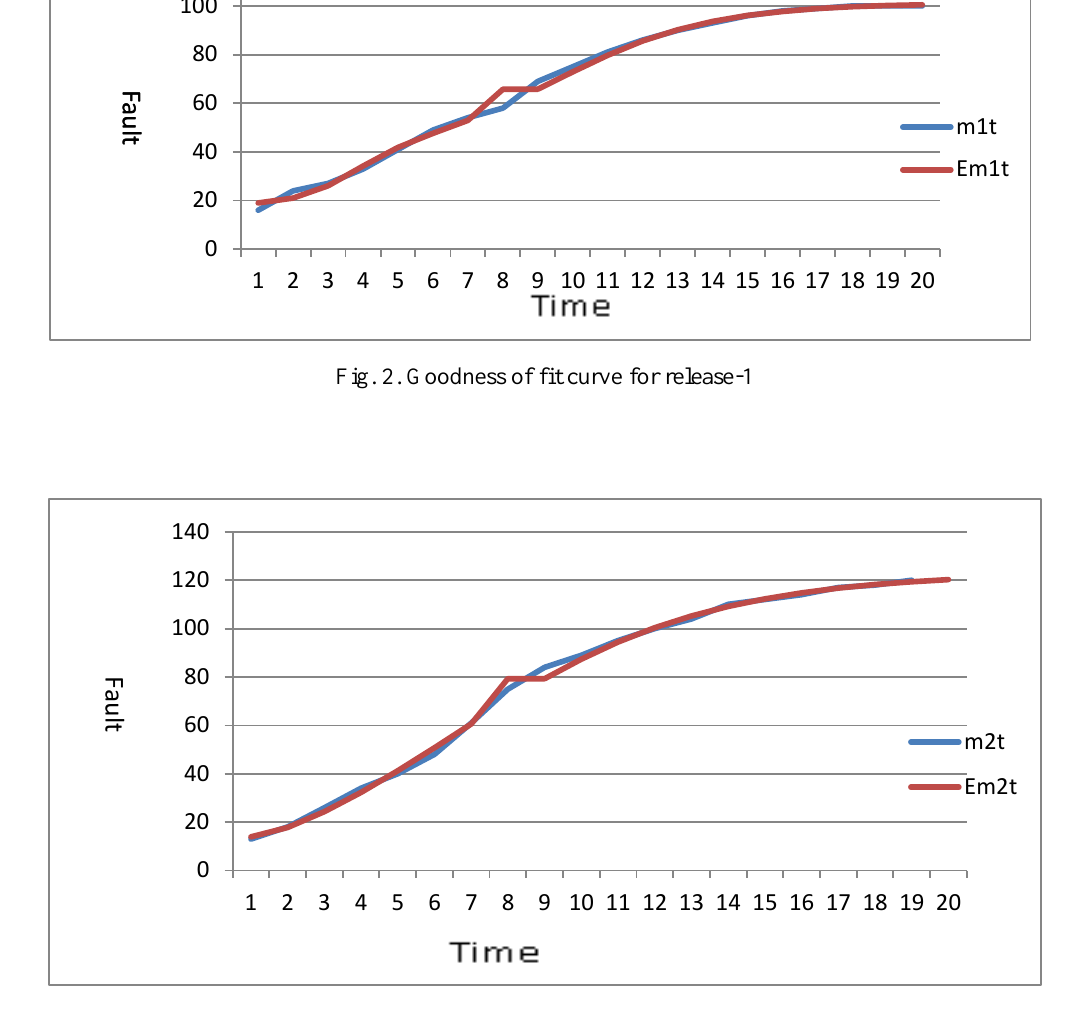
Fig. 3. Goodness of fit curve for the release